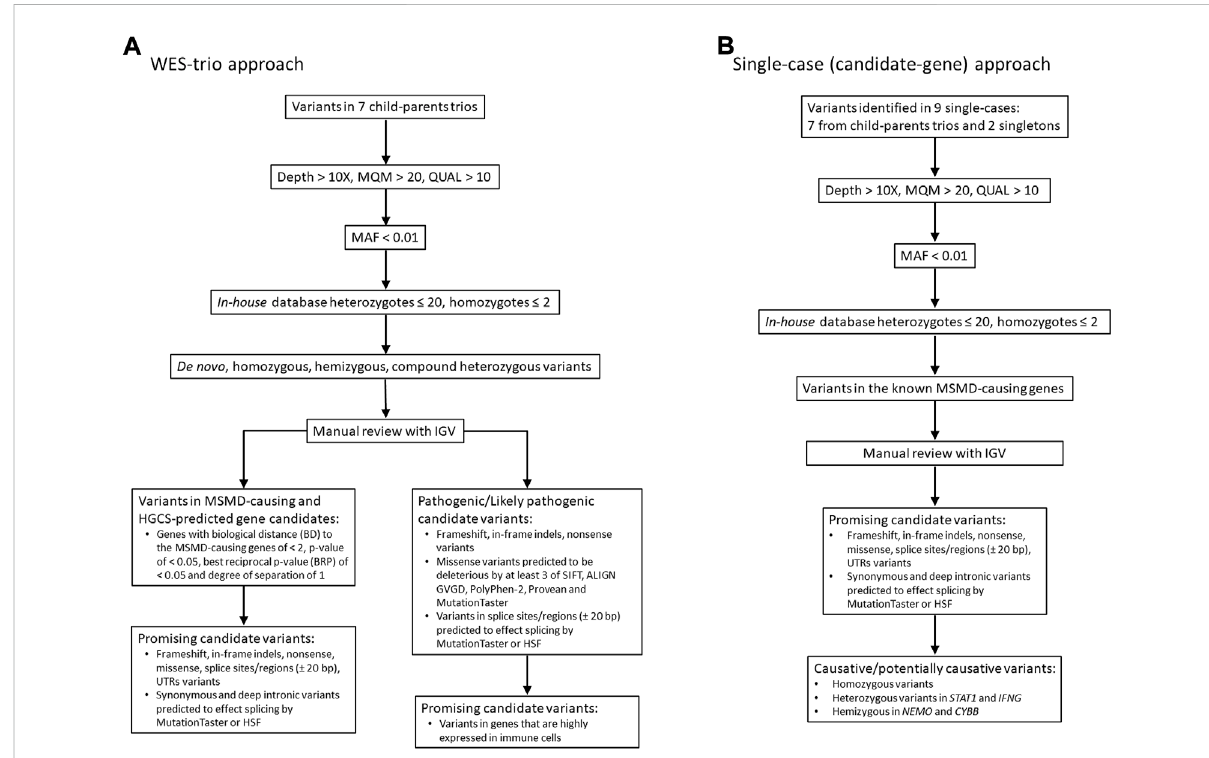
FIGURE 1 Work fl ow of WES analysis in 7 case-parental trios (A) and nine single cases (B) . The fi ltered candidate rare variants in single-case and trio-based approaches are shown in Table 2 and Table 3, respectively. See also supplementary material for fi ltering query results in each trio/single